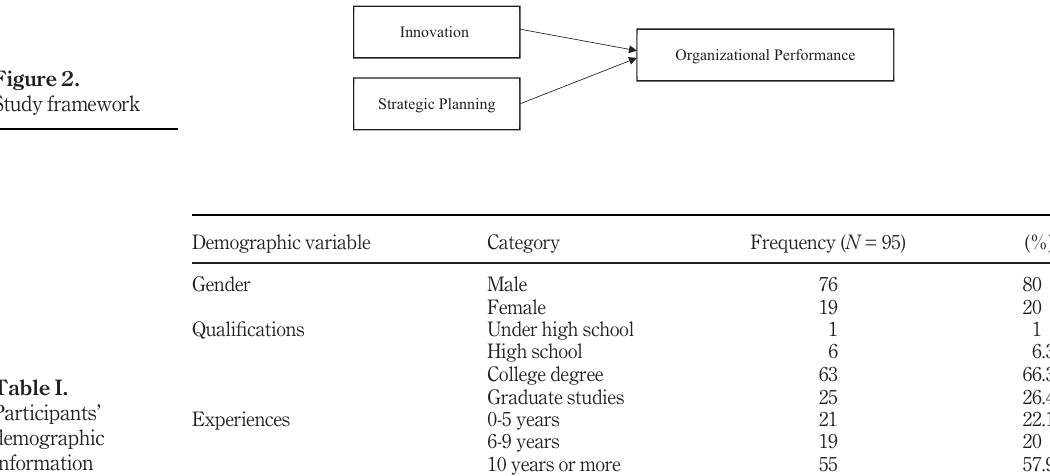
Innovation Strategic Planning